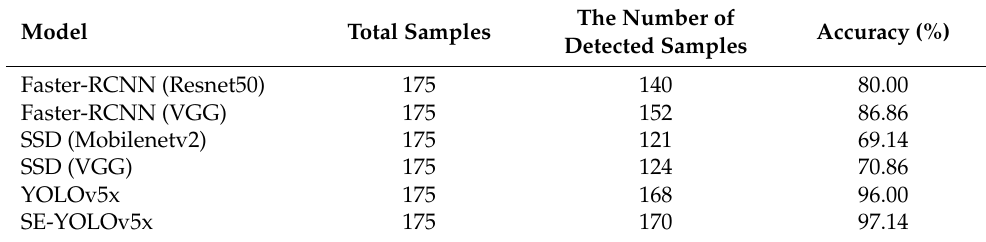
Table 4. Test results of different deep learning models in lettuce stem emerging point localization.